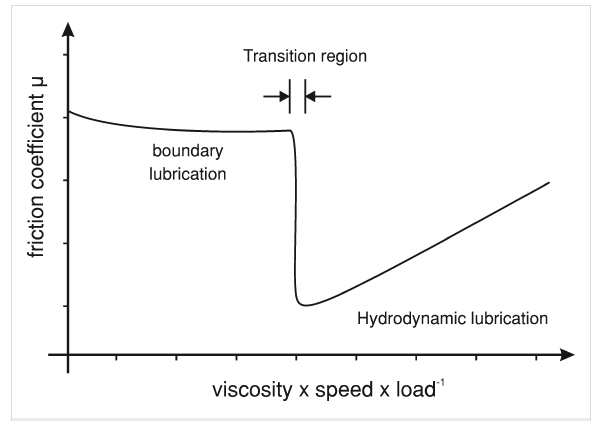
Figure 3: Regions of hydrodynamic and boundary lubrication of two fluid mediated smooth surfaces (Stribeck curve). With decreasing sliding velocity and increasing load the mediating fluid film becomes thinner, allowing regions of direct contact between the two surfaces. Within the transition region the friction coefficient rapidly increases, usually to a value smaller than unlubricated surfaces. This region is also referred to as elasto-hydrodynamic lubrication. It is not yet fully understood in which of the two “regions” the adhesive organs of insects